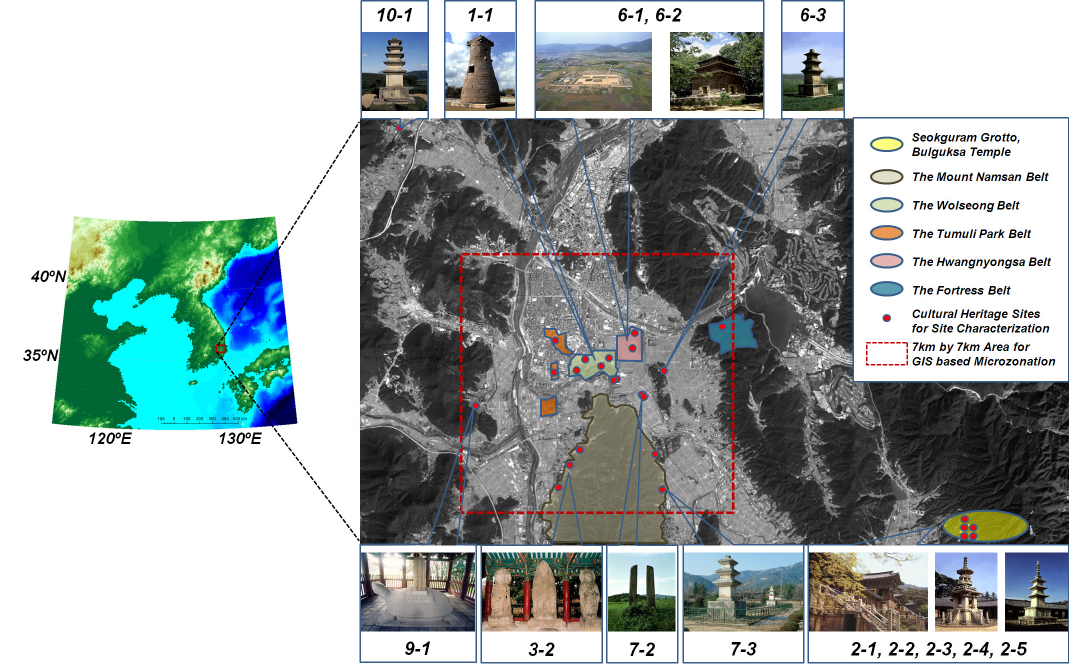
Fig. 1. The satellite picture of Gyeongju historical areas, the location and foreground of typical cultural